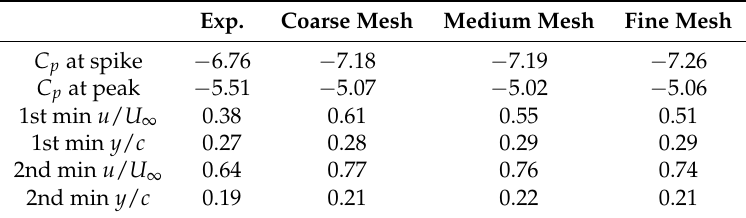
Table 5. Numerical and experimental values for the main points used for